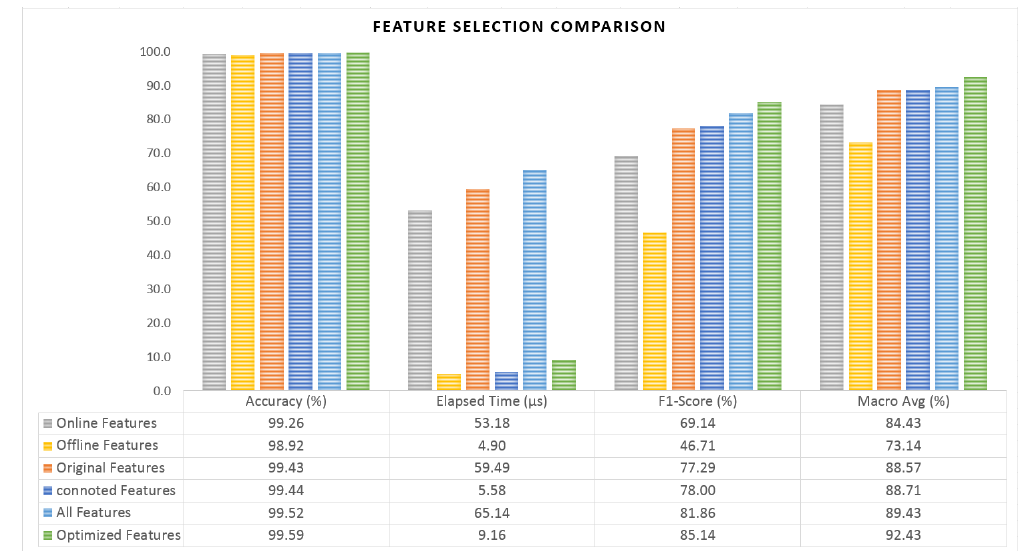
Figure 12. Comparison result summary of feature